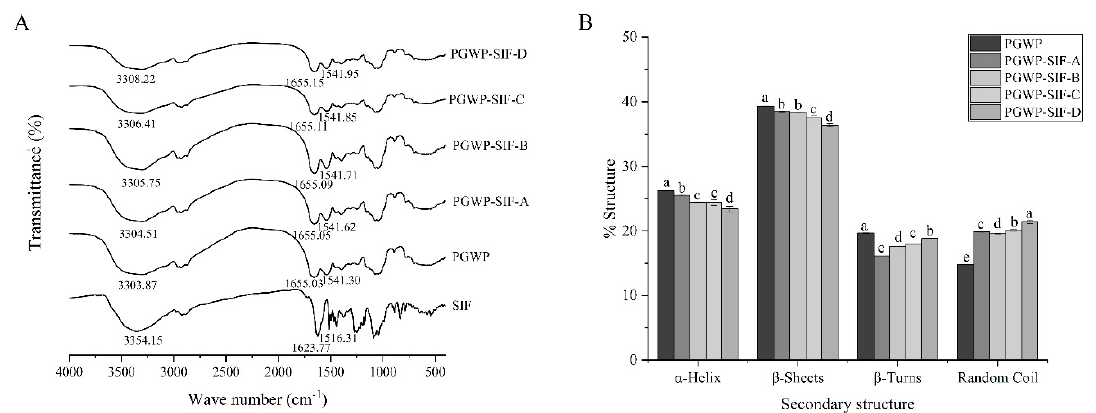
Figure 4. FT-IR spectra of SIF, PGWP, and PGWP-SIF ( A ) and the contents of secondary structures of PGWP and PGWP-SIF ( B ). Different subscript letters indicate a significant difference ( P < 0.05). Error bars represent standard deviation of the means.